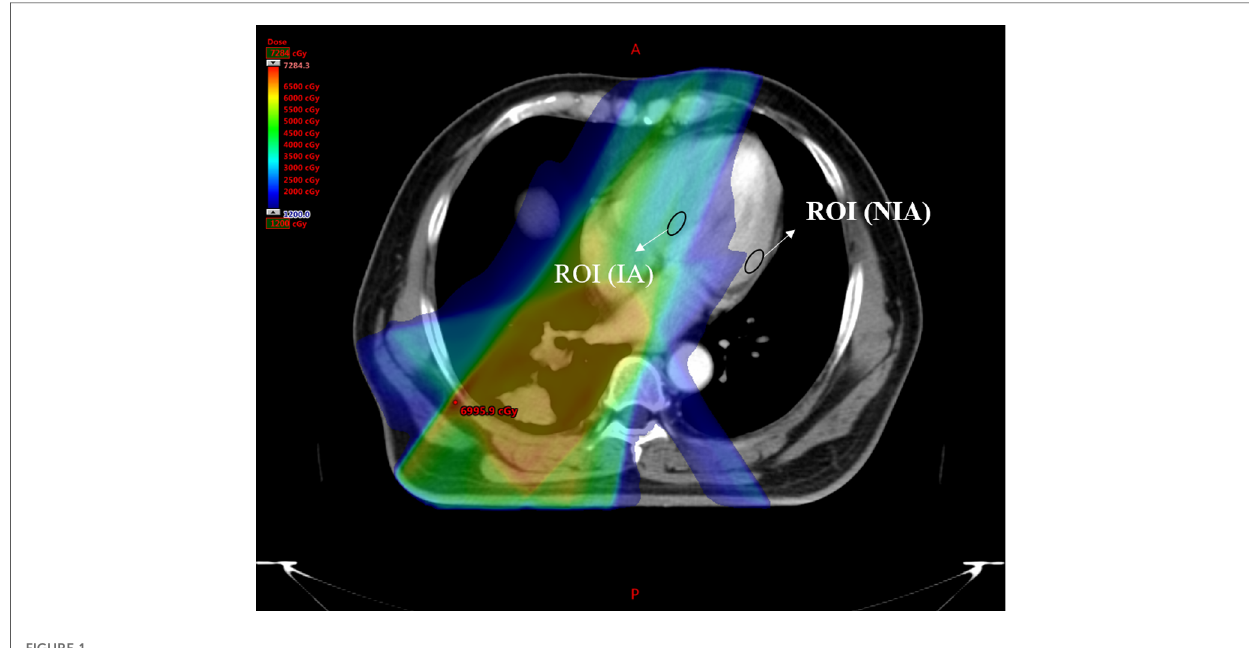
FIGURE 1 Zone map of IA and NIA. IA, irradiated areas; NIA, nonirradiated